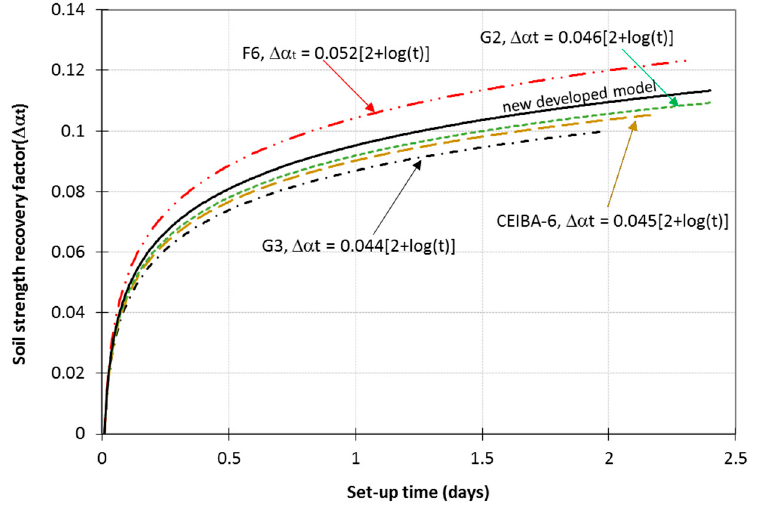
Figure 5. Soil strength recovery models in Equatorial Guinea derived from the field data.